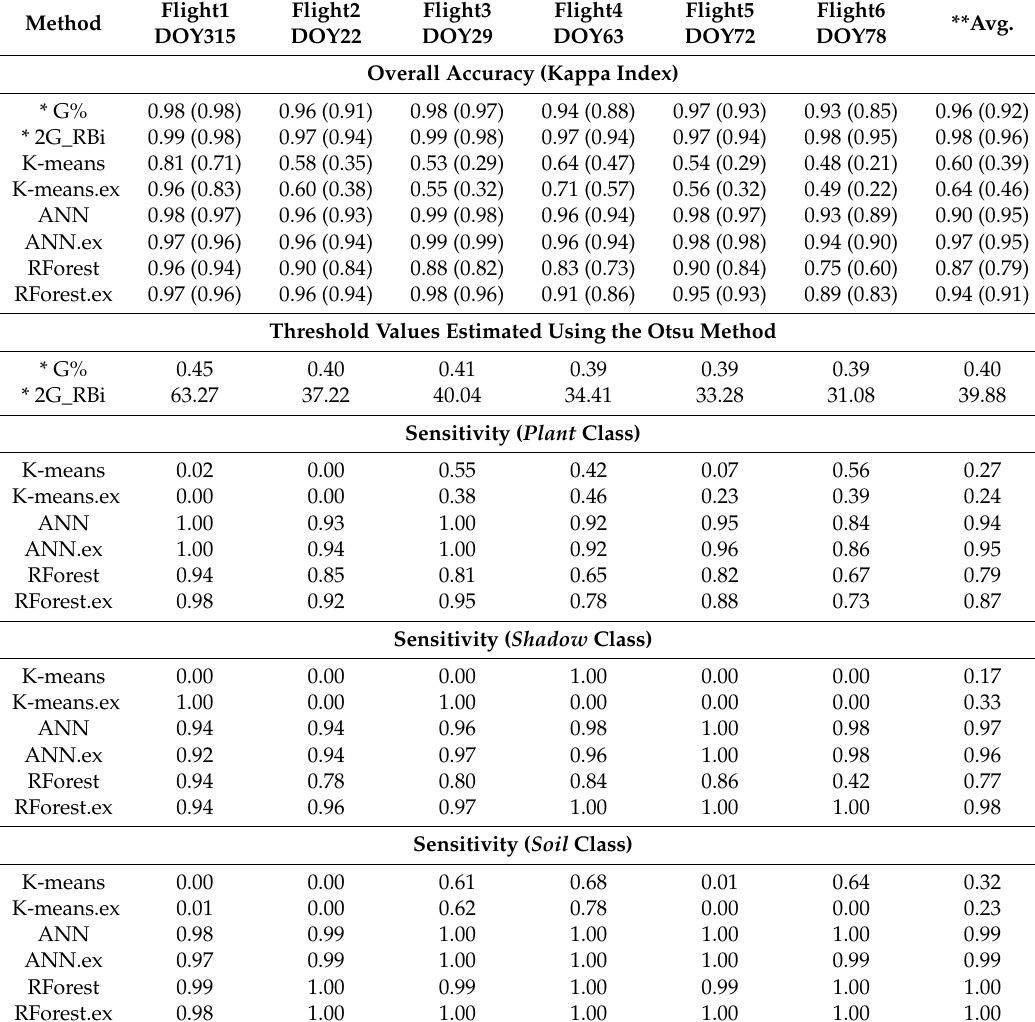
Table 3. Performance of the different classification methods.